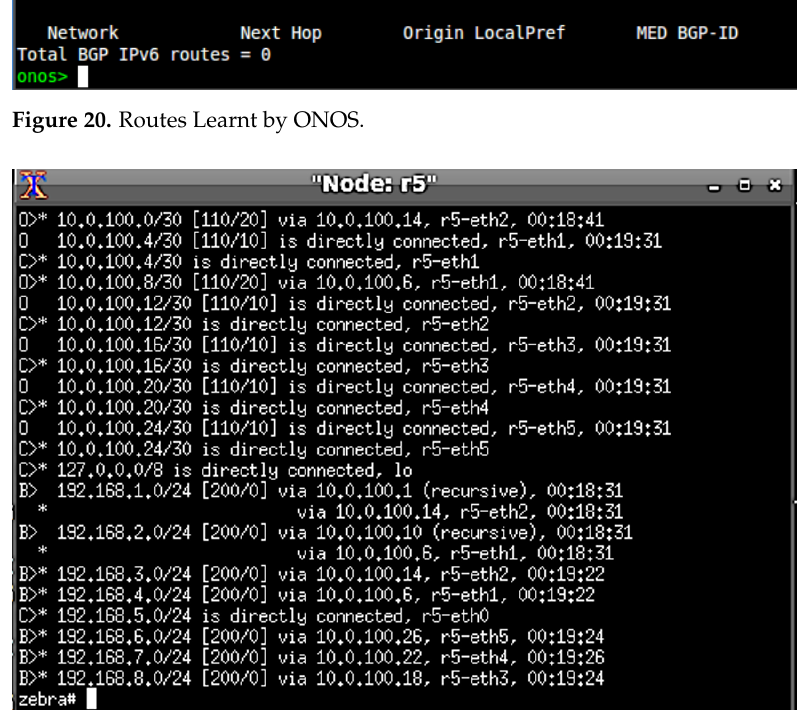
Figure 21. Routes learnt by reflector router (r5) in the legacy